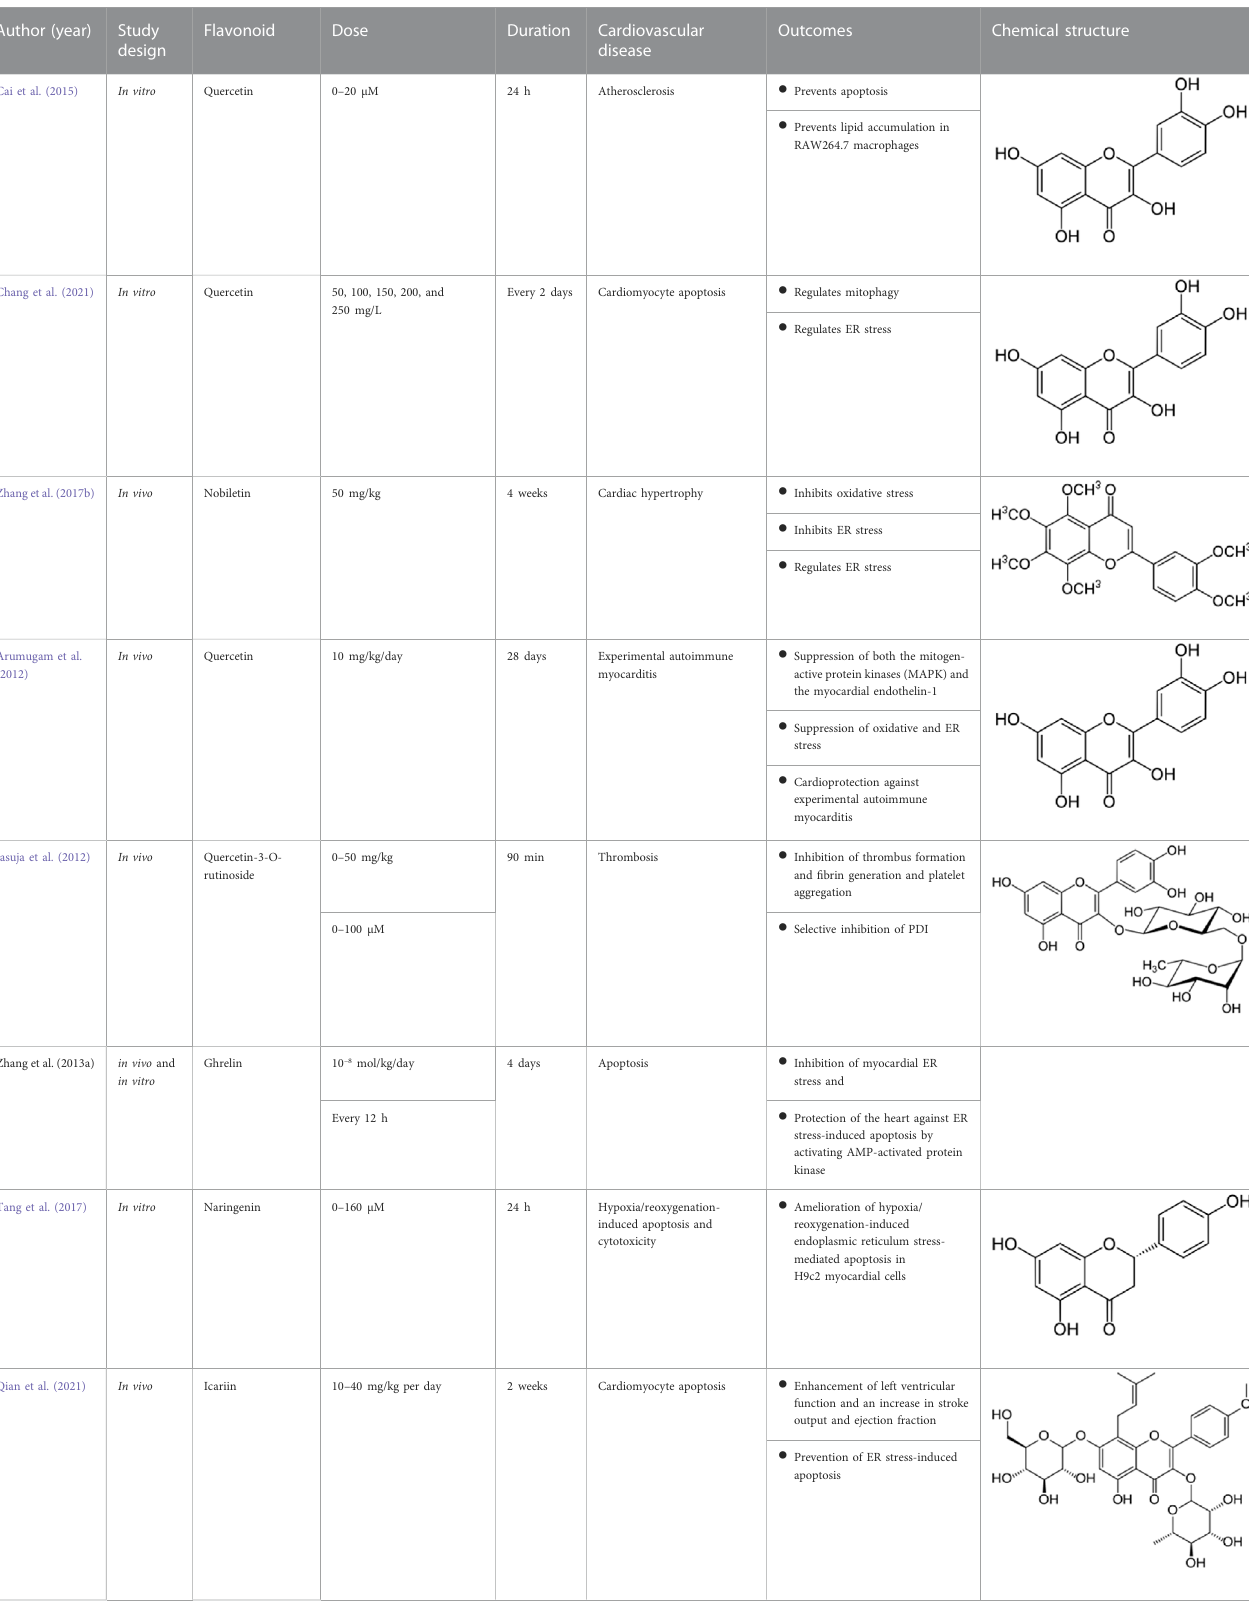
TABLE 1 Mechanisms of fl avonoids included in cardiovascular